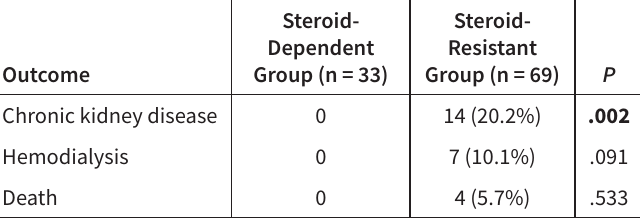
FSGS, focal segmental glomerulosclerosis. Bold entries represent significant p